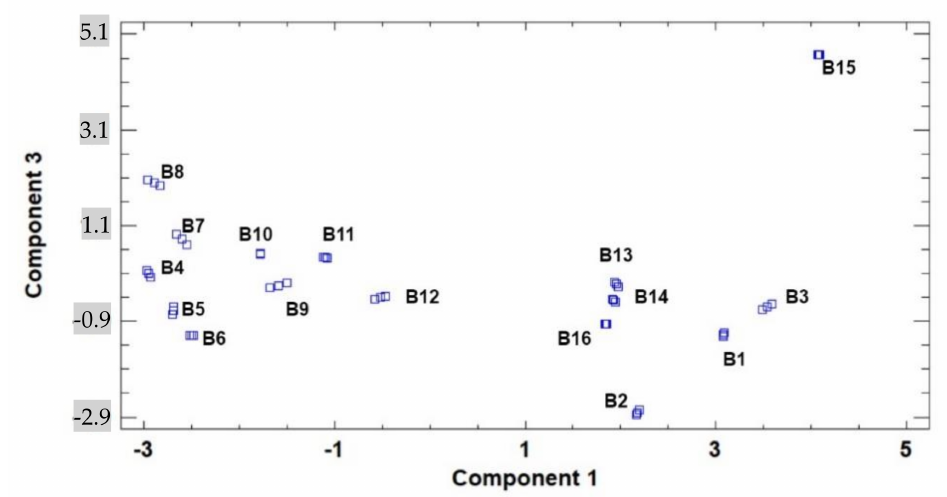
Figure 4. Two-dimensional scatterplot of principal components 1 and 3 for the tested variables at different maturation stages of cardoon blades (samples B1–B16).